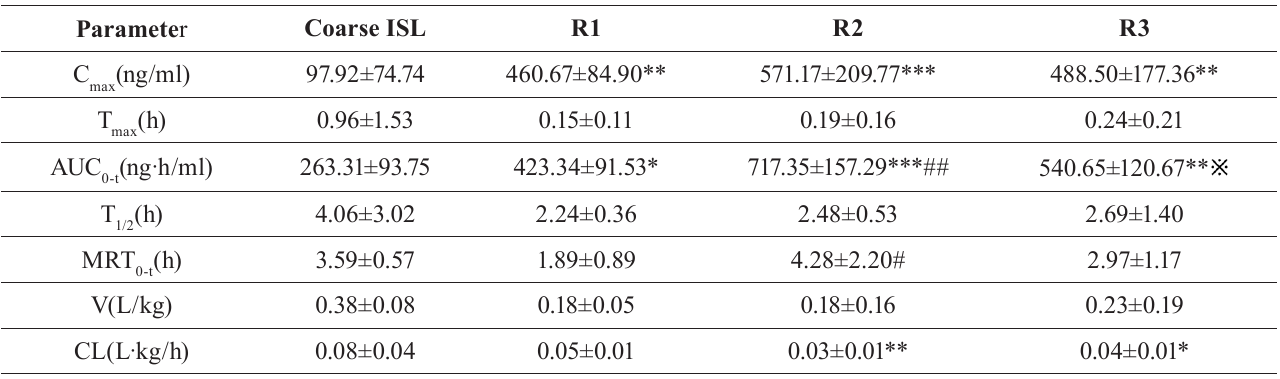
TABLE III - Pharmacokinetic parameters following oral administration of the ISL solution and ISL nanocrystals (mean ± SD, n = 6)